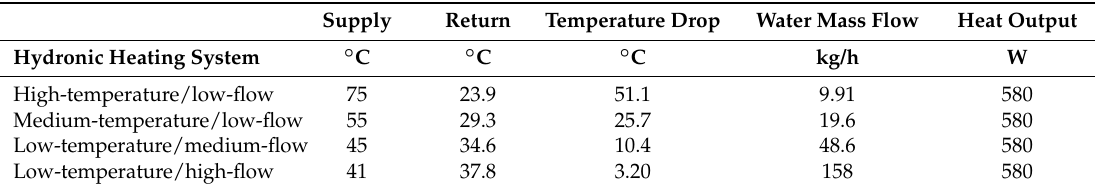
Table 2. Operating conditions of a conventional radiator consisting of two panels and two